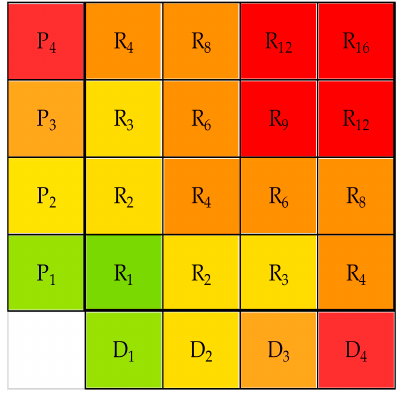
Figure 10. Risk Matrix.